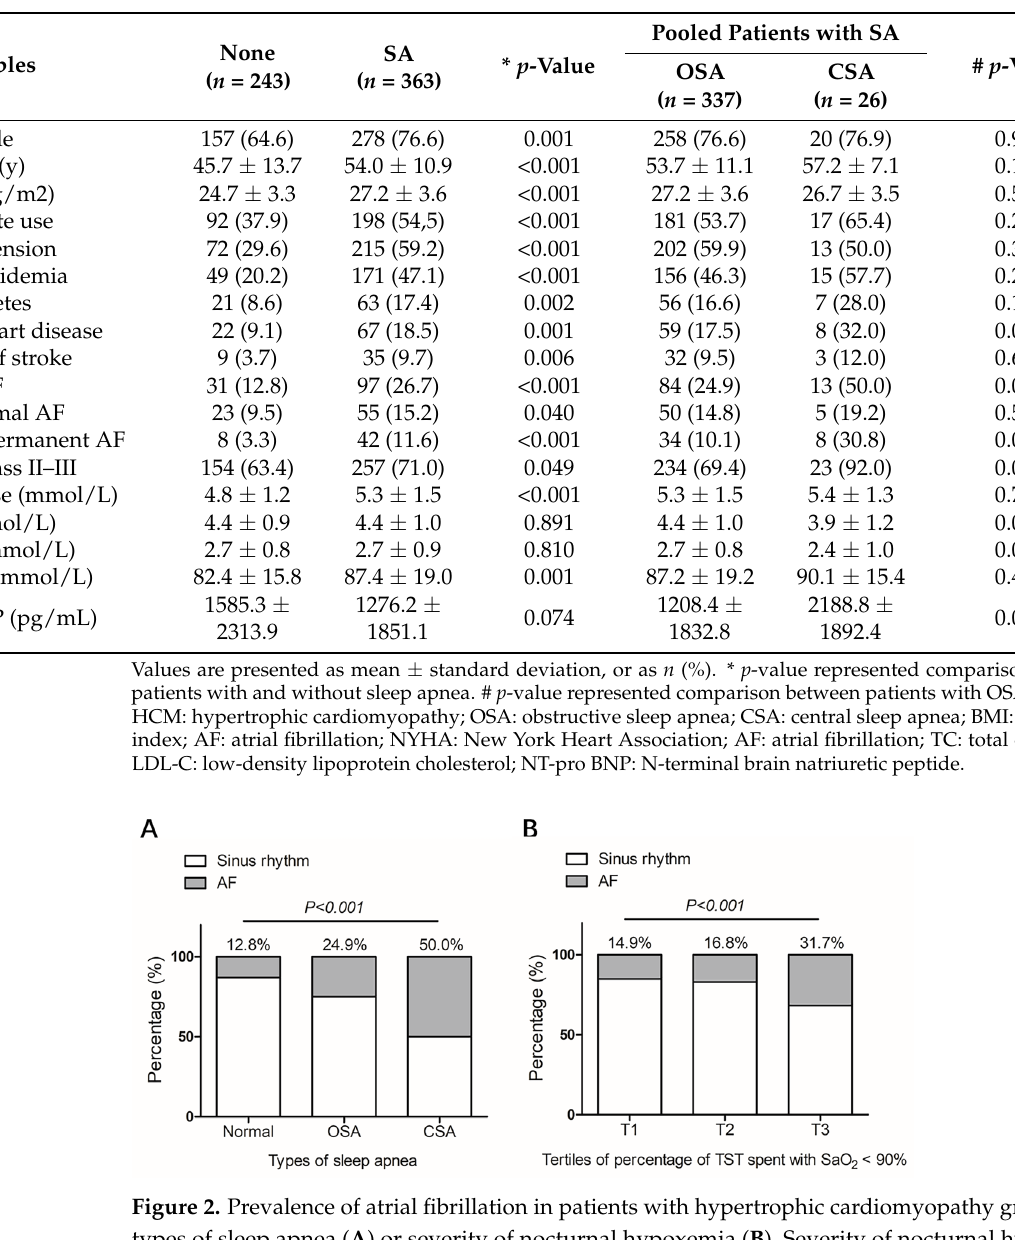
Table 1. Clinical characteristics of patients with HCM grouped according to types of sleep apnea.